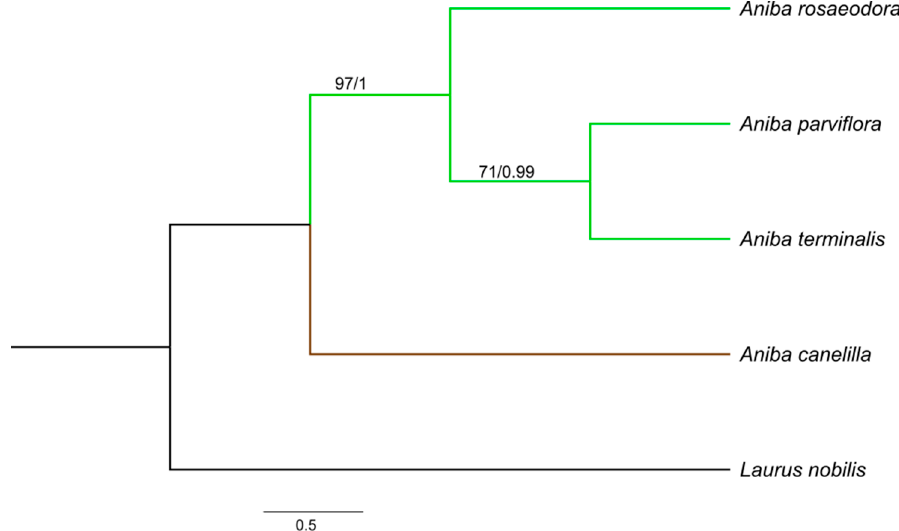
Figure 5. Bayesian consensus tree based on rbcL + matK + trnH − psbA sequences of species of Aniba and Laurus nobilis (outgroup). Bootstrap support values ( ≥ 70%)/Bayesian posterior probabilities (>0.9) are shown above the branches.